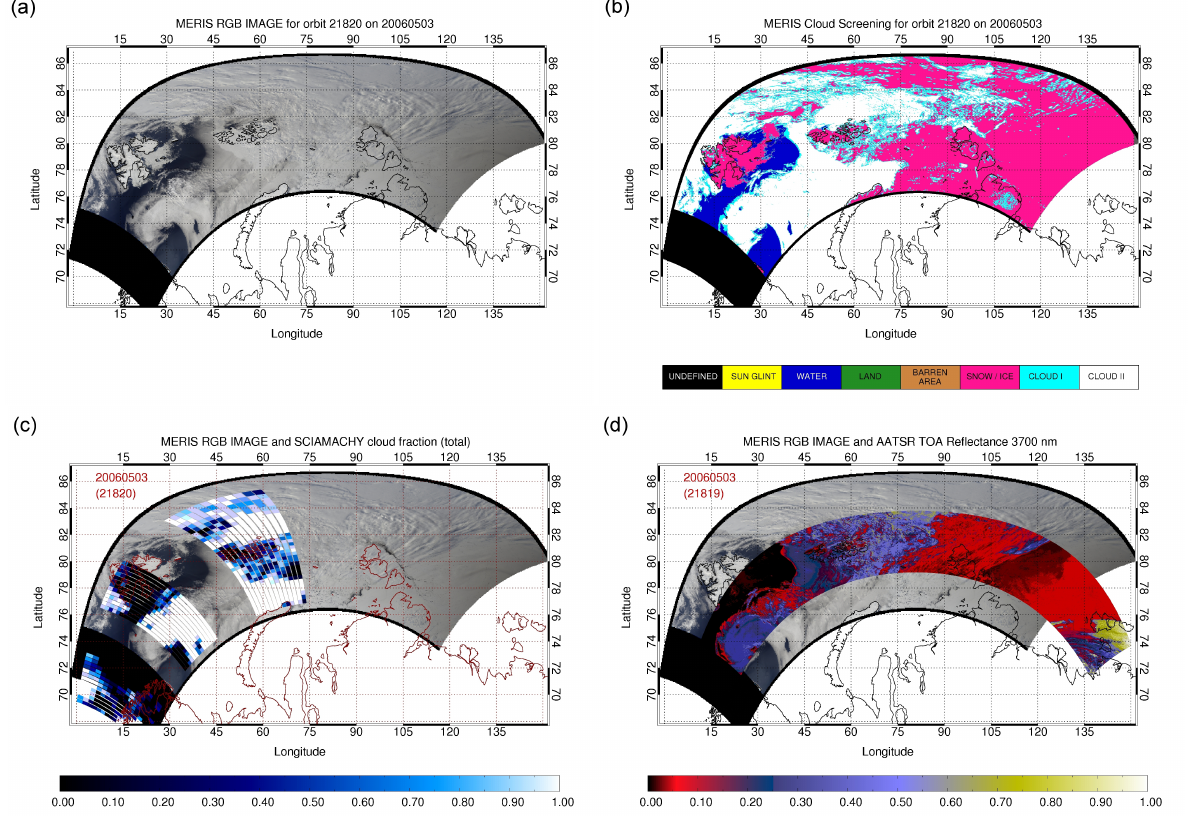
Fig. 7. Maps showing the Arctic Ocean on the 3rd of May 2006 (orbit 21820): (a) MERIS RGB image, (b) MICROS-MERIS cloud screening, (c) MICROS-SCIAMACHY cloud fraction (at nadir) and (d) top-of-atmosphere reflectance at 3.7 microns measured by AATSR/ENVISAT